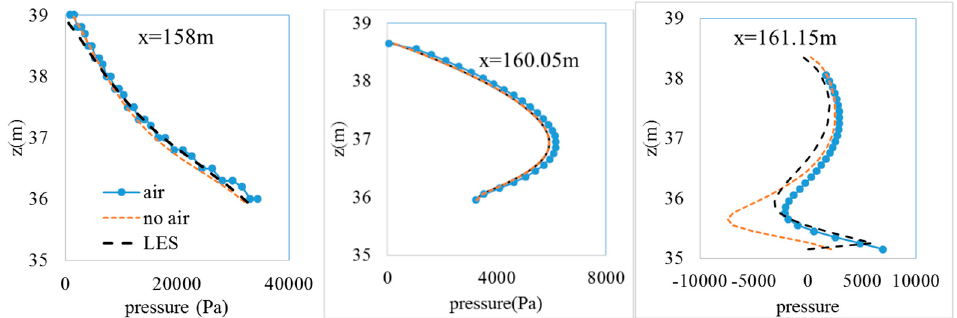
Figure 13. Pressure distribution in the vertical axis in the first step of the stepped segment.